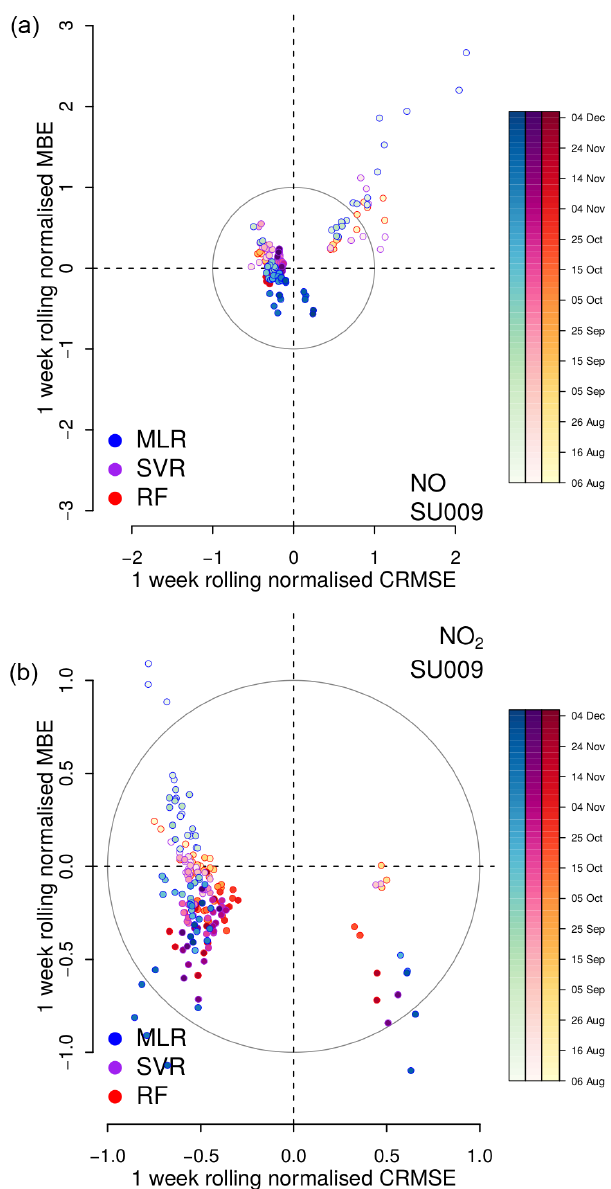
Figure 6. Target plot for timeseries of 1 week rolling goodness-of- fit indexes of NO (a) and NO 2 (b) estimate by SU009, in Zurich urban